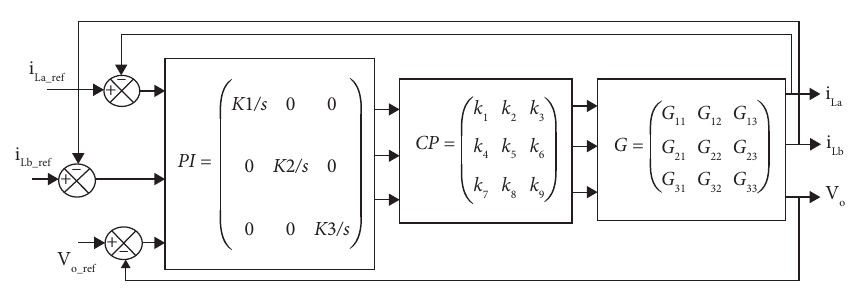
Figure 9: Scheme of the closed loop in the second and third